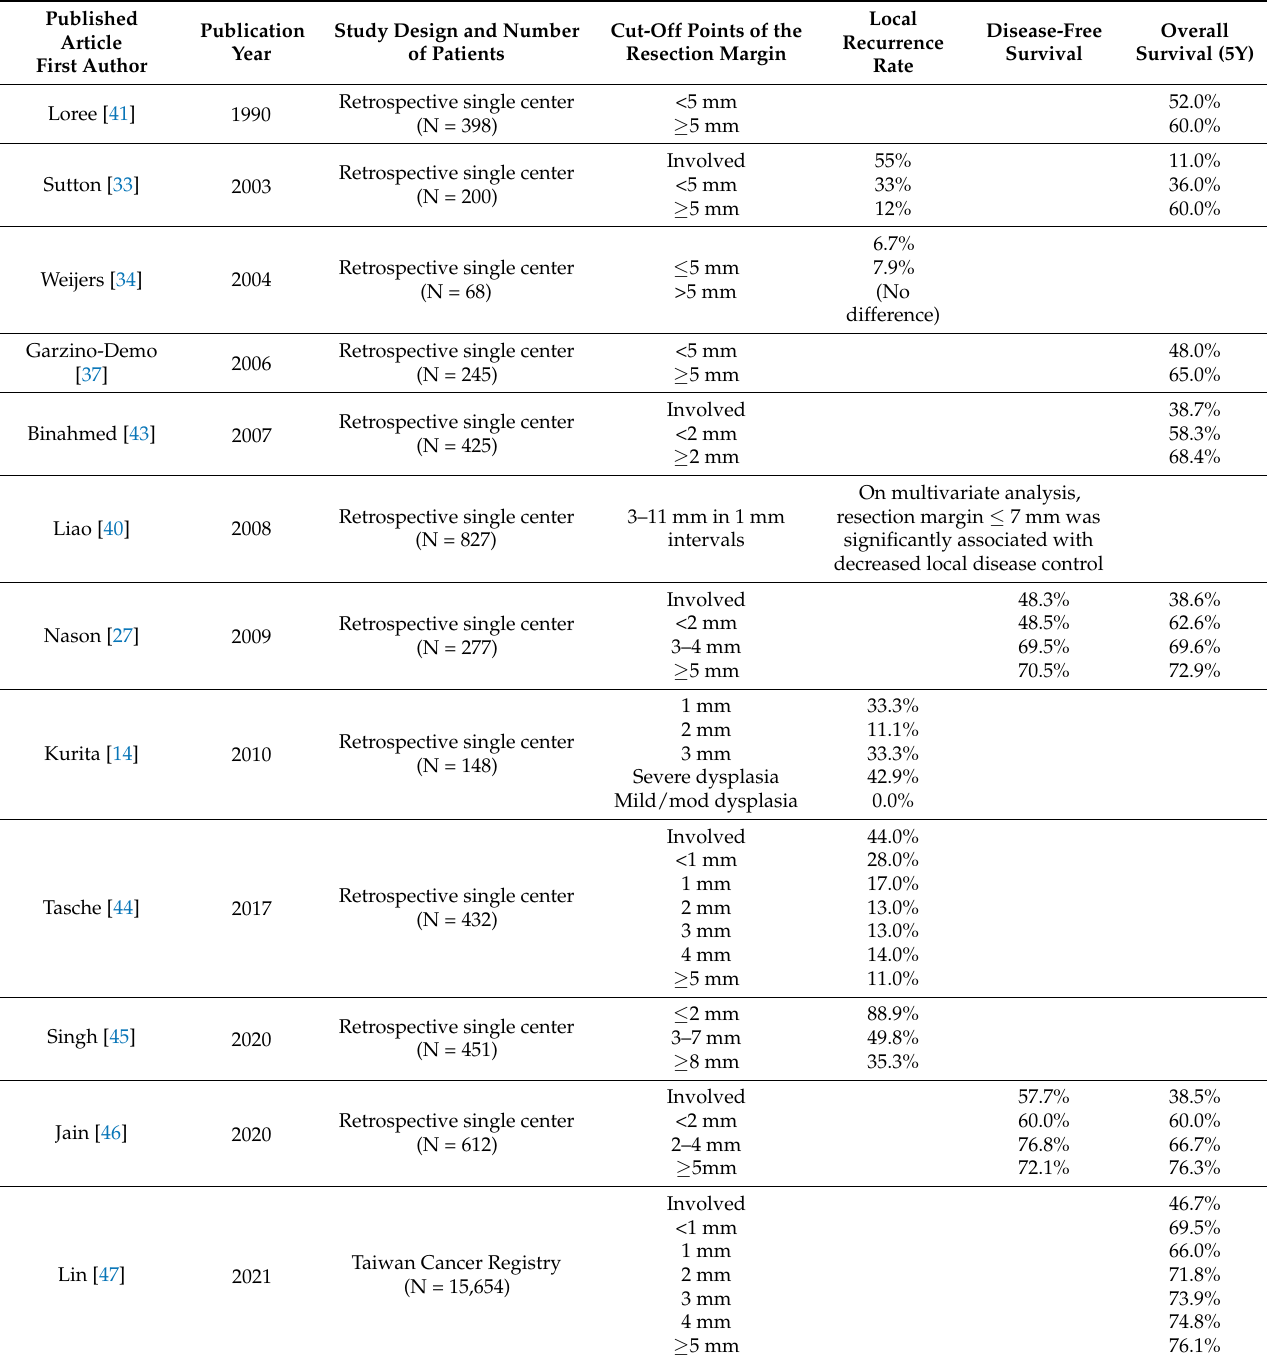
Table 1. Prognostic significance and local recurrence rate according to the cut-off points of resection margin length in surgically treated oral squamous cell